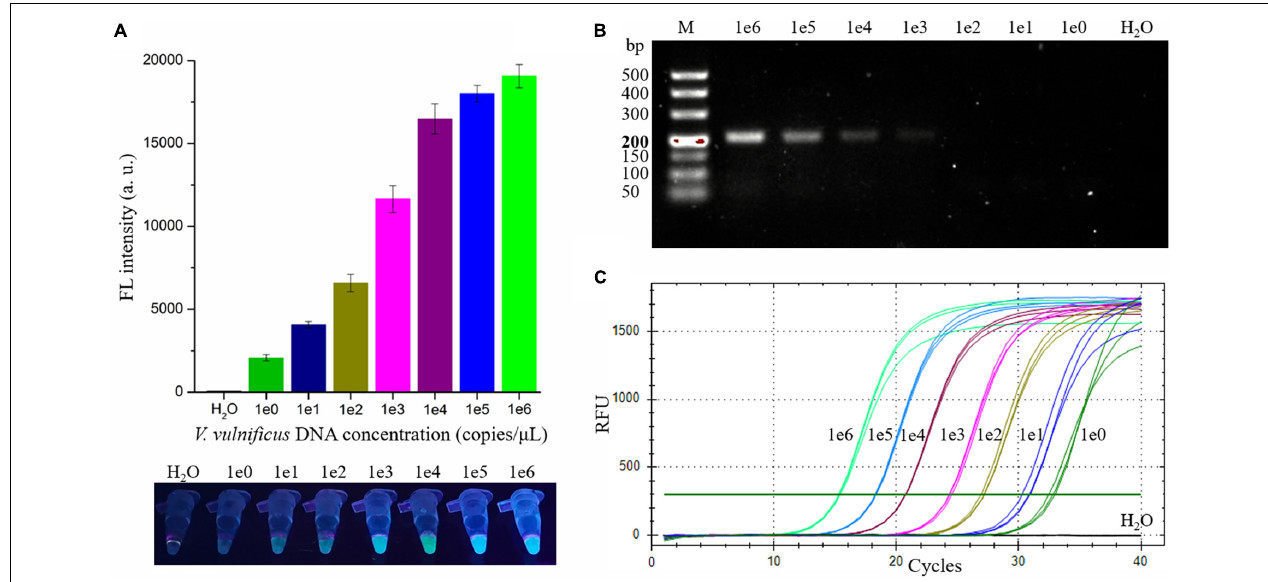
FIGURE 4 | Evaluating the sensitivity of the RAA-CRISPR/Cas12a, RAA, and qPCR assay in V. vulnificus detection. 2 µ L of nuclease-free water and 1 × 10 0 to 1 × 10 6 copies/ µ L of V. vulnificus genomic DNA were used as templates in these assays. (A) The sensitivity of the RAA-CRISPR/Cas12a assay. The results were detected using a multifunctional microplate reader (upper) or a UV torch (below). (B) The sensitivity of the RAA assay. RAA reaction time was 20 min, consistent with the RAA-CRISPR/Cas12a assay. The results were analyzed using gel electrophoresis. (C) The sensitivity of the qPCR assay. qPCR was conducted with the CFX96 real-time PCR detection systems, and the amplification curves of each sample were shown in this figure. Data is one representative of three experiments.